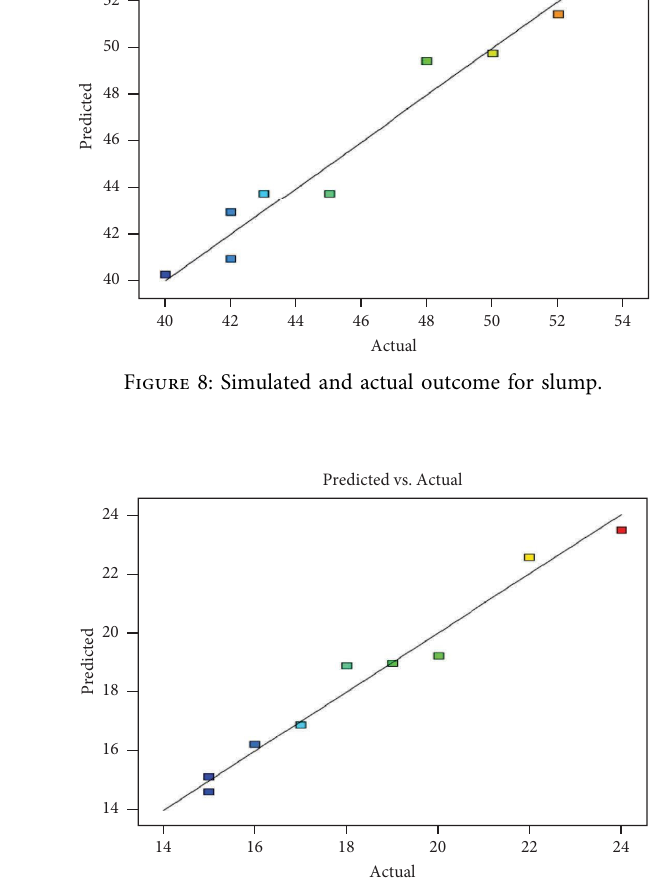
Predicted vs. Actual